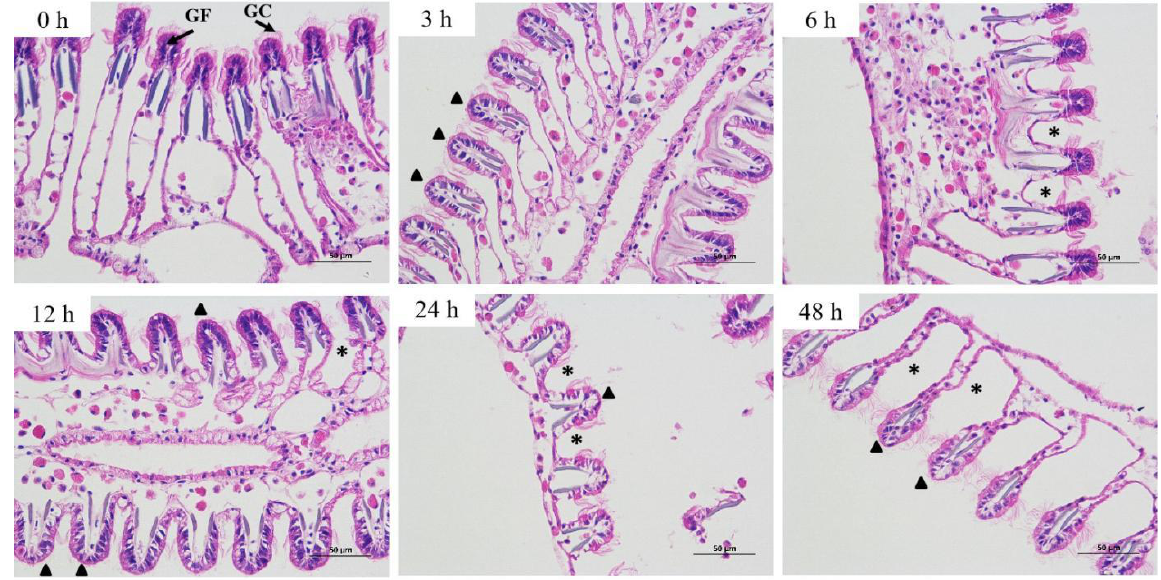
Figure 4. Effects of salinity on gill histomorphology. GF: gill filament; GC: gill cilium. The asterisks represent increased gill filament space, and the triangles represent the decrease in gill cilium number. Scale bars = 50 µ m; magnification: 400 × .